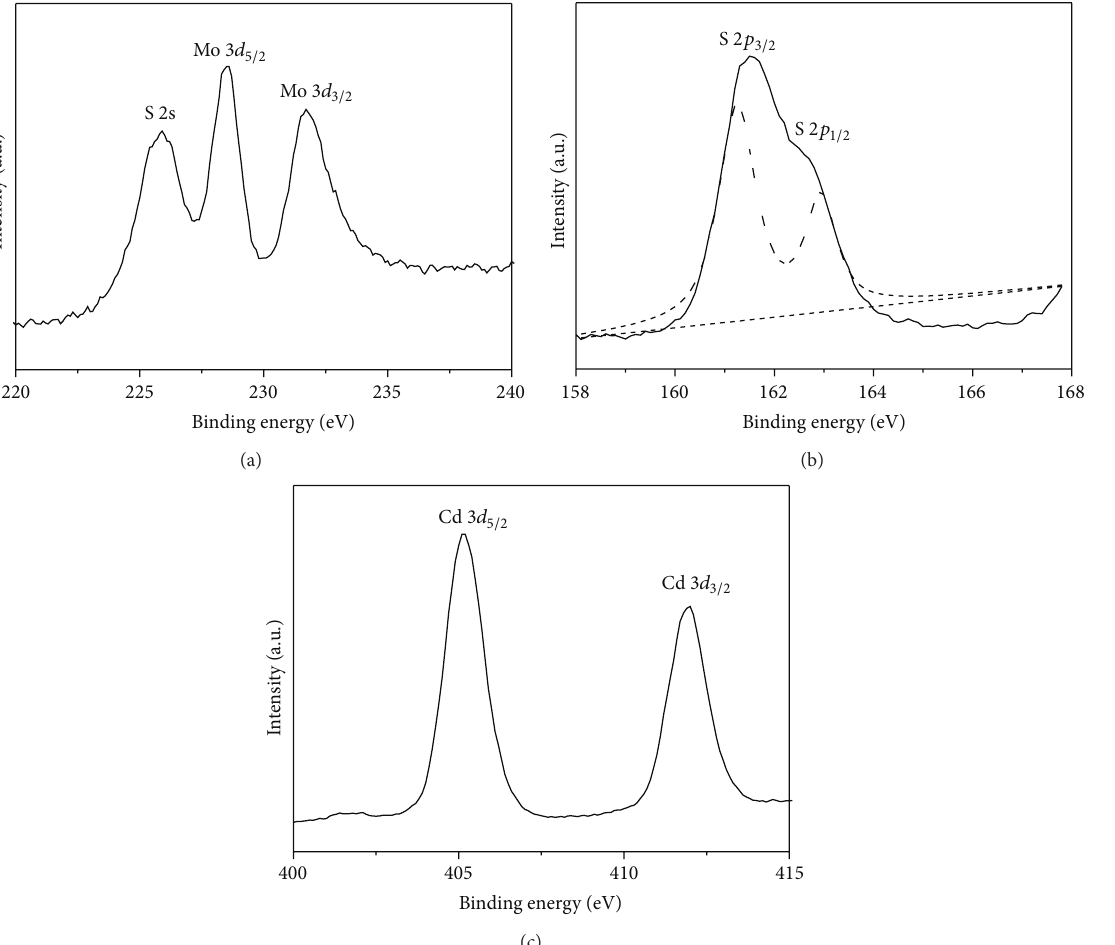
Figure 2: XPS spectra of MoS 2 /CdS: (a) Mo 3𝑑 , (b) S 2𝑝 and (c) Cd 3𝑑